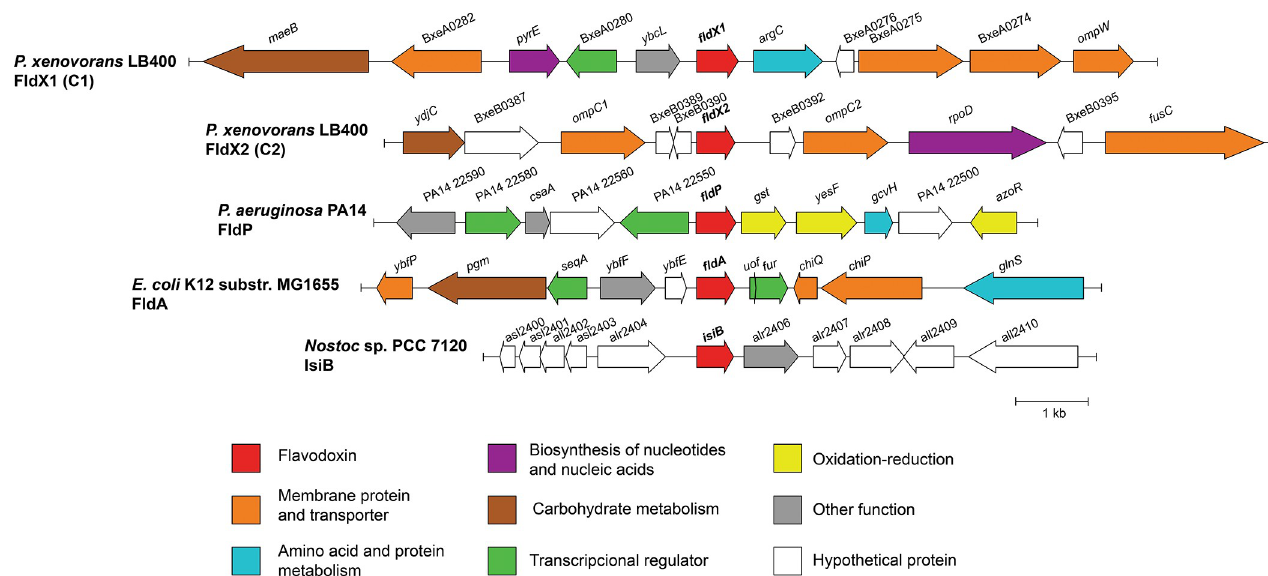
Fig 2. Genomic context of flavodoxins of P . xenovorans LB400. Gene encoding FldX1 is located in the major chromosome, while FldX2-encoding gene is located in the minor chromosome of strain LB400. Five genes upstream and five downstream of flavodoxin coding gene are shown. For comparison, the genomic context of other three flavodoxins with assigned biological functions is shown.